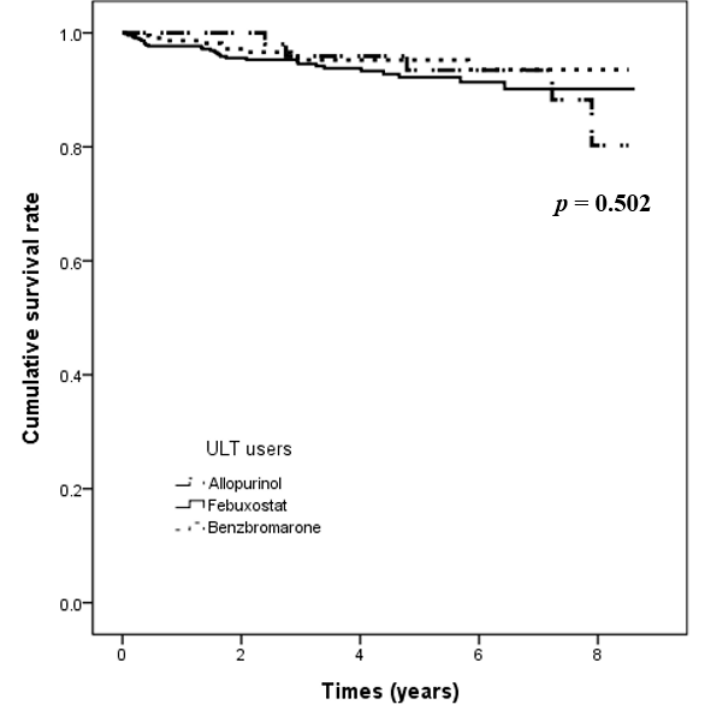
Figure 2. Kaplan–Meier curve for the 9-year AF incidence rate derived through a log-rank test among the three ULT user groups. Abbreviations: AF, atrial fibrillation; ULT, urate-lowering ther- apy.